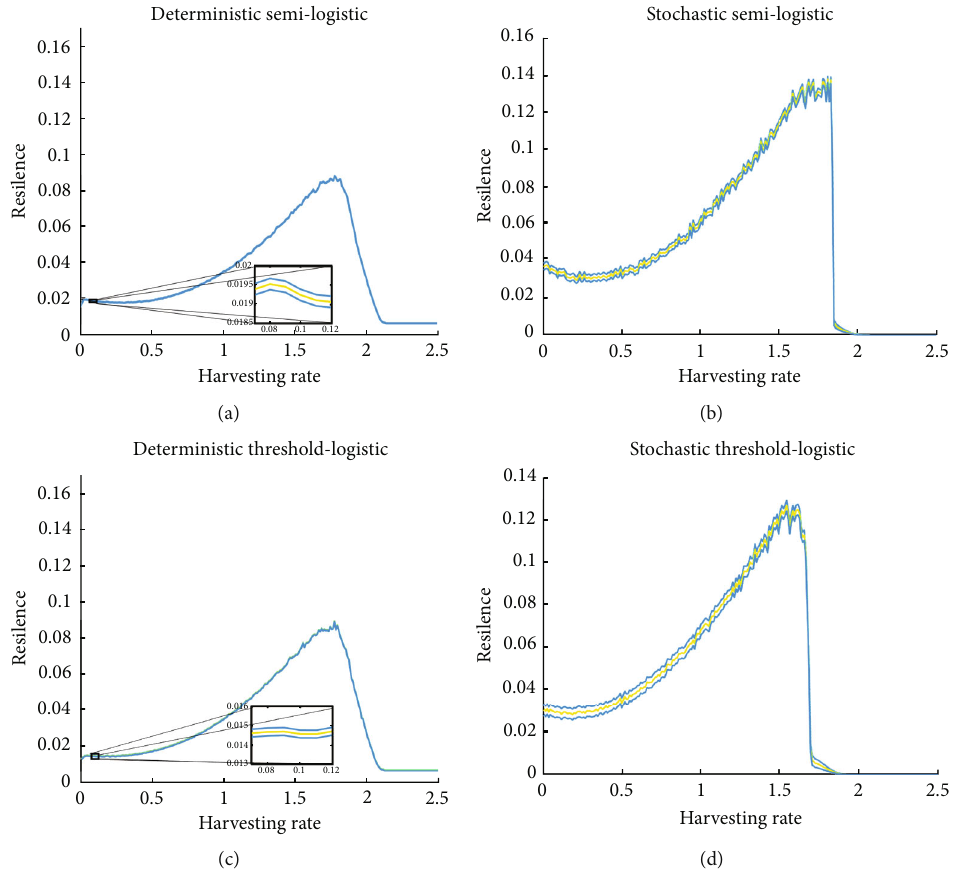
Figure 5: The resilience for all deterministic (a, c) and stochastic (b, d) growth rates is calculated by using the algorithm described in Appendix B.1. The mean (yellow curve) and the standard deviation (68%)(light blue curves) of the resilience are shown for all